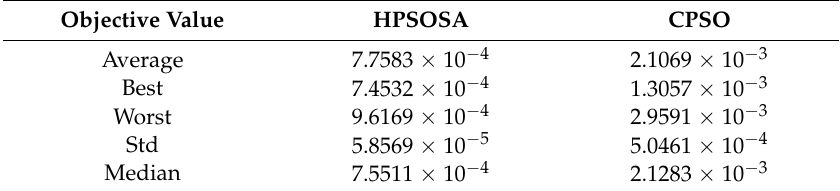
Table 6 lists the best values of parameters estimated by HPSOSA and other five optimization